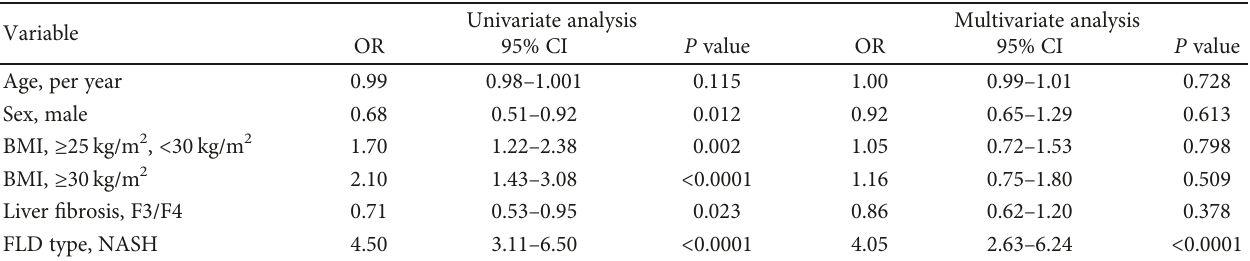
Table 4: Associations of ASH and NASH with